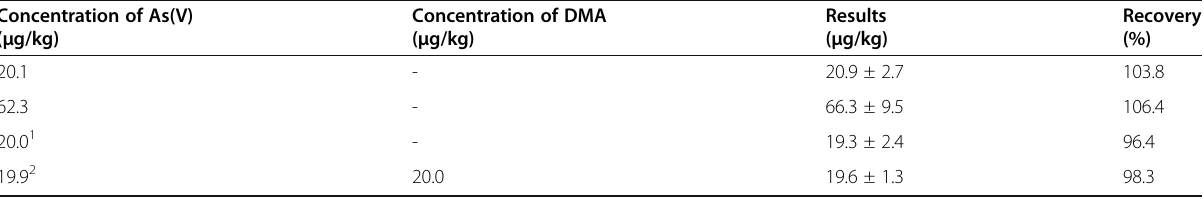
Table 3 Determination of As(V) absorbed on the SPE filter disk by fs-LA-ICP-MS Concentration of As(V) ( μ g/kg)